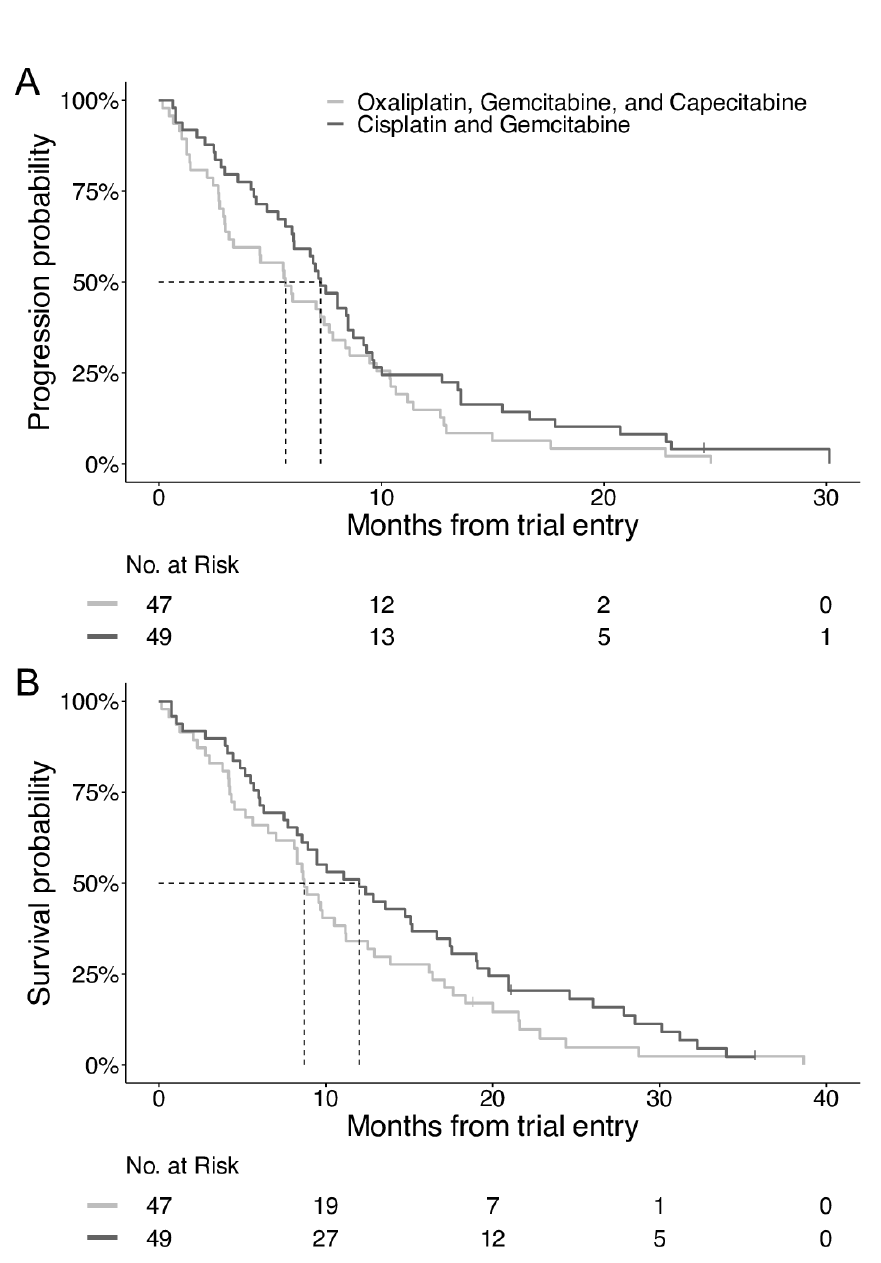
Figure 2. Kaplan – Meier plots of the progression-free survival (A) and overall survival (B). Figure 2. Kaplan–Meier plots of the progression-free survival ( A ) and overall survival ( B ).